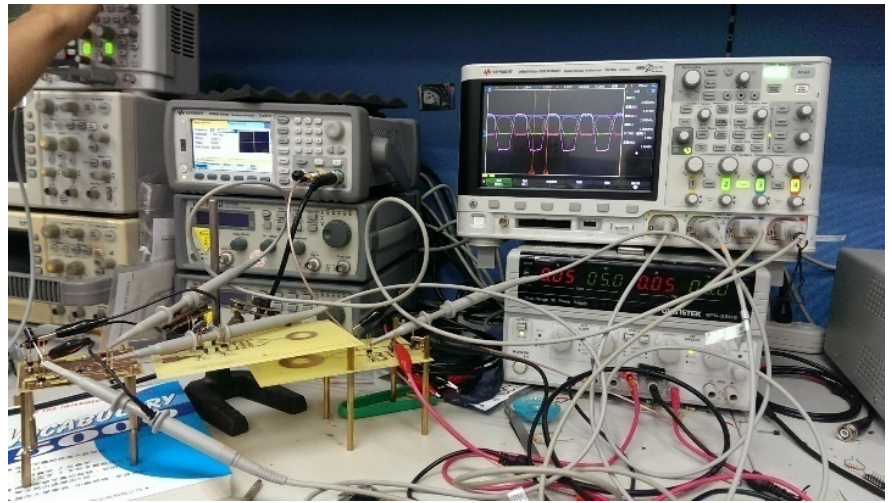
Figure 27. Actual measurement board (overall system). Sensors 2019 , 19 , x FOR PEER REVIEW